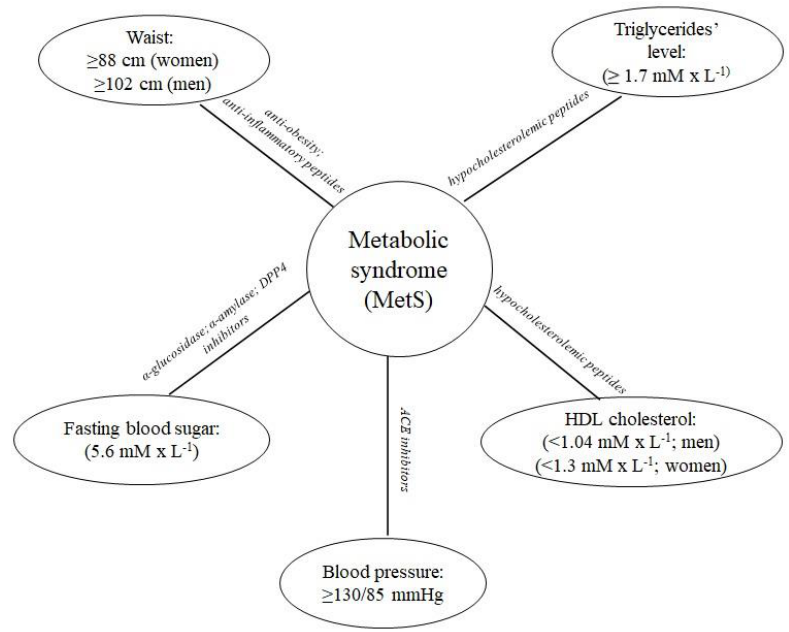
Figure 1. Metabolic syndrome criteria and related preventive agents according to Huang [4].